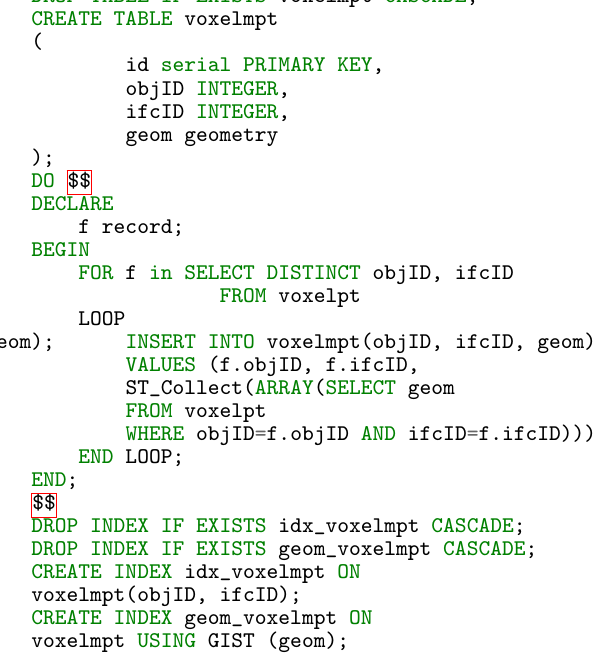
Figure 2. Example of a table created in PostgreSQL to store POINT layout.